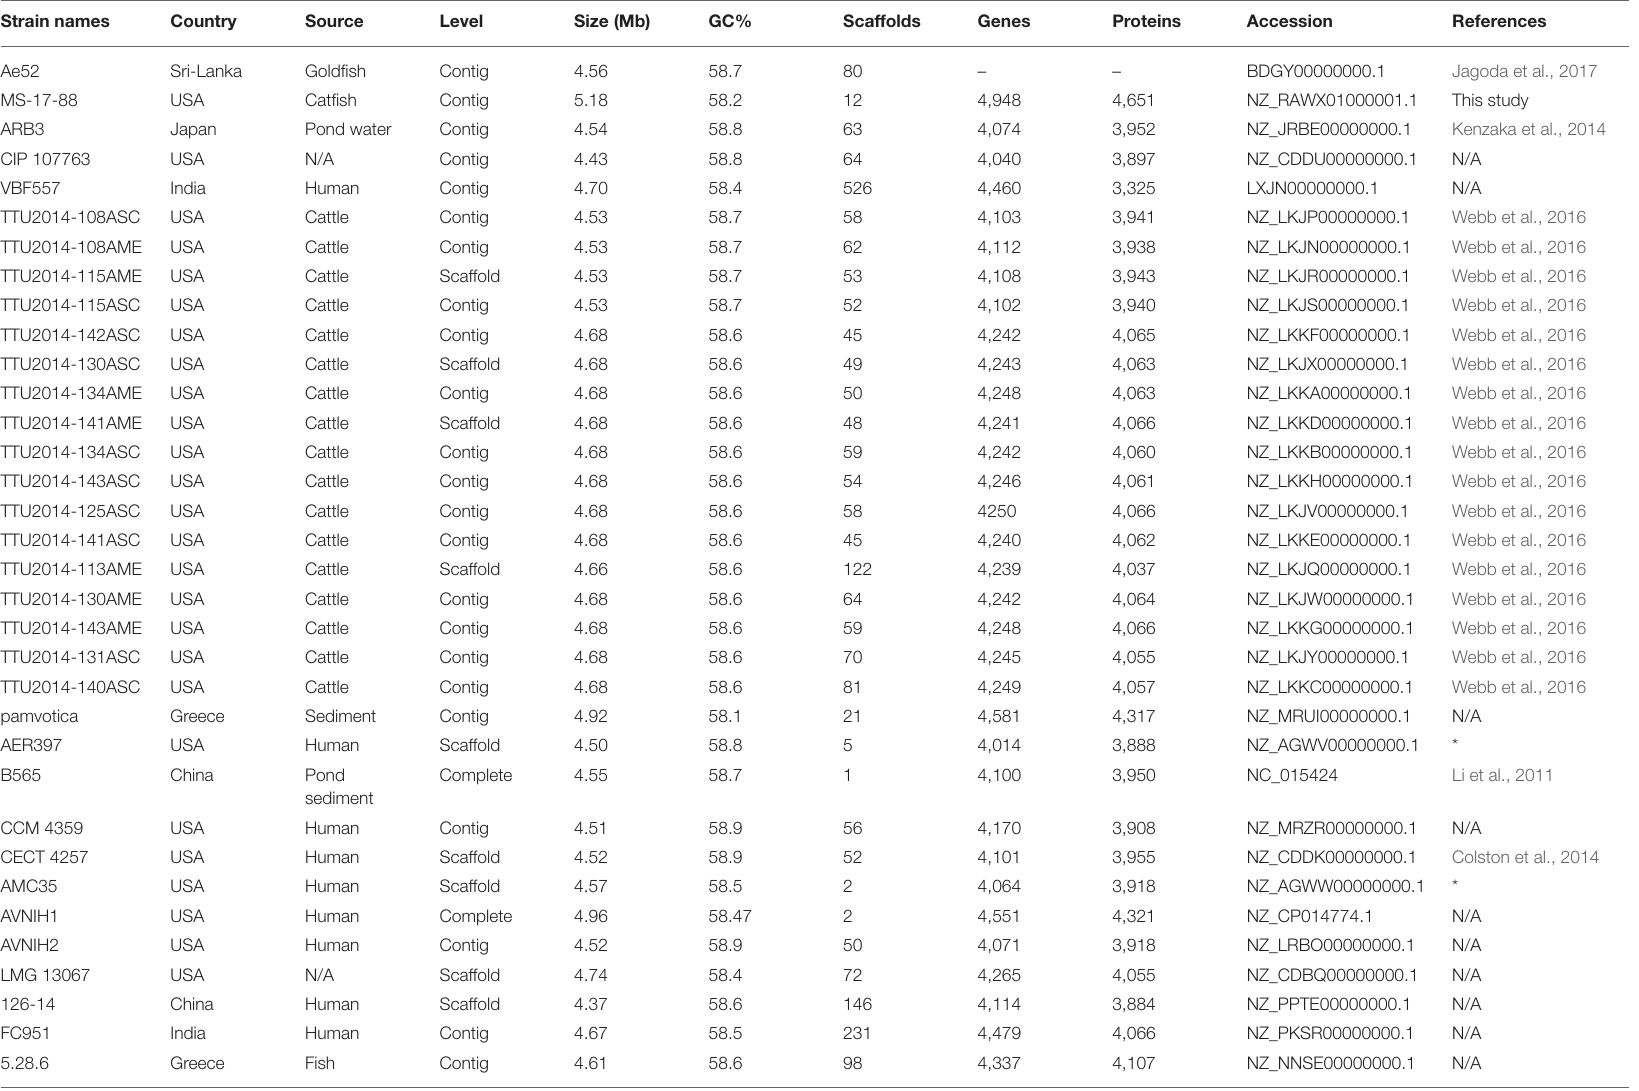
TABLE 1 | The 53 A. veronii genomes used in comparative genomic